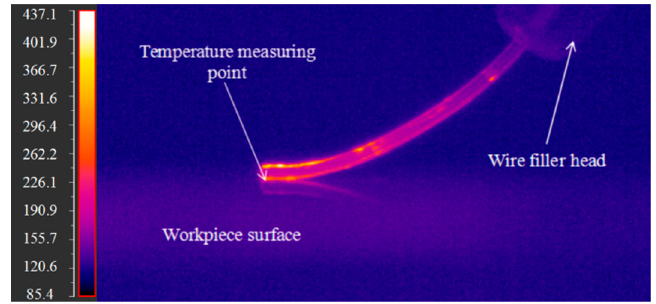
Figure 4. Thermal image of welding wire.